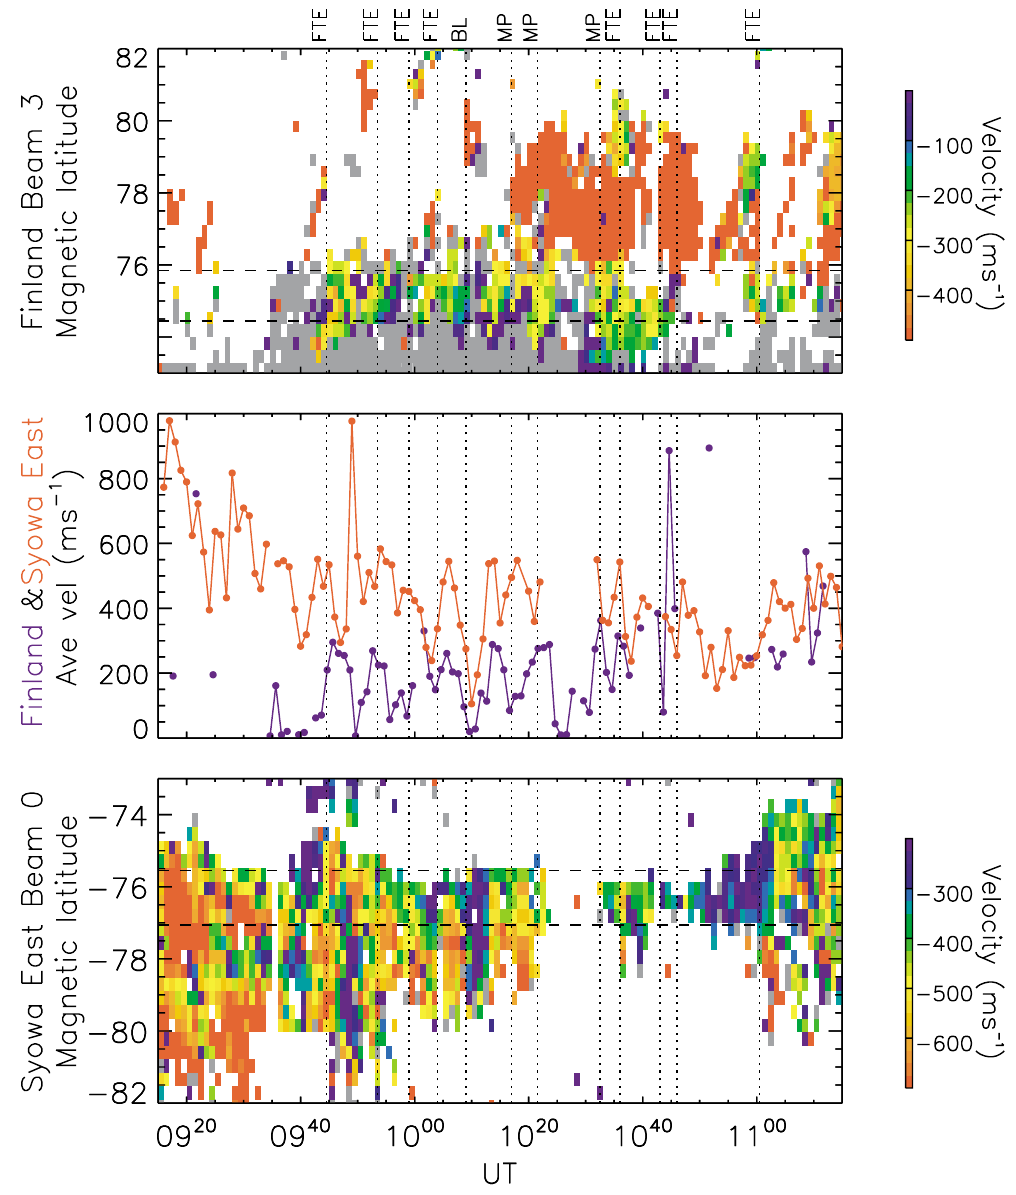
Fig. 6. (a) Velocity data from beam 3 of the Finland radar, in a format similar to that in Fig. 5, but with a revised colour scale which reveals the pulsing of the line-of-sight flow in the band of lower-latitude scatter. (c) Velocity data from beam 0 of the Syowa East radar, presented in the format of (a), albeit with a different colour scale and a reversed latitude axis. (b) The mean velocity averaged over the latitude range indicated by dashed horizontal lines in (a) and (c) (and given positive values in this case, though in each case the flow is directed away from the radars). The indigo trace corresponds to the Finland average velocities, whilst the red trace corresponds to the Syowa East average velocities. Superimposed on each panel are the times of note identified in the Cluster observations, as in Fig. 3.